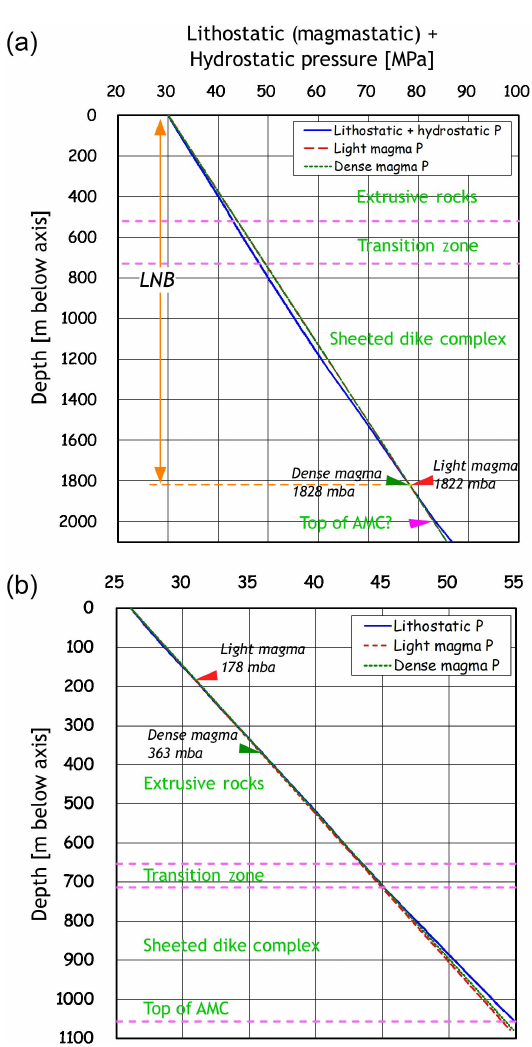
Figure 9. Estimated lithostatic–magmastatic pressure variations for Sites (a) 504B and (b) 1256D when they were at the ridge axis. (a) Us- ing the lithodensity logs obtained during Leg 111, density structures of the upper crust were estimated by integrating all density data > 2000kgm − 3 with depth, assuming water depth at the ridge axis of 3000m, identical to that of the present Costa Rica Rift. The up- permost 50m thick flows were emplaced out of the neovolcanic zone (Ayadi et al., 1998), and so they were eliminated from the lithostatic pressure estimate. Hole 504B lavas and dikes are nearly aphyric, relatively primitive (Mg# (100 × Mg / [ Mg + Fe ] ) 68%–56%, MgO 8%– 9.5%, FeO ∗ (total Fe as FeO) 8%–10.5%), and are among the most depleted end-members of NMORB (Dick et al., 1992; Umino, 2003). Magma density was estimated using the program adiabat_1ph (Smith and Asimow, 2005) run in MELTS (Ghiorso and Sack, 1995) mode for representative primitive and differentiated compositions at an appropriate AMC depth up to the surface and at liquidus temperatures. The lower crust gabbro is presumed to be close to the bottom of the hole at 1526m below seafloor; however, it is yet to be reached. Consequently, the AMC beneath the ridge axis is assumed to be at 1060m in depth. Oxygen fugacity was assumed to be 2 log10 units below the quartz– fayalite–magnetite buffer (Christie et al., 1986). (b) Hole 1256D was penetrated through a 15Ma ultrafast-spread (22cmyr − 1 ) crust formed at the East Pacific Rise. Assuming the water depth at ridge axis of 2600m, the densities of magmas at the AMC pressures of 53.7MPa are estimated as 2698 and 2703kgm − 3 for primitive (FeO ∗ 8.39%) and differentiated (FeO ∗ 10.2wt%) magmas, respectively. Please refer to Umino et al. (2008) for more